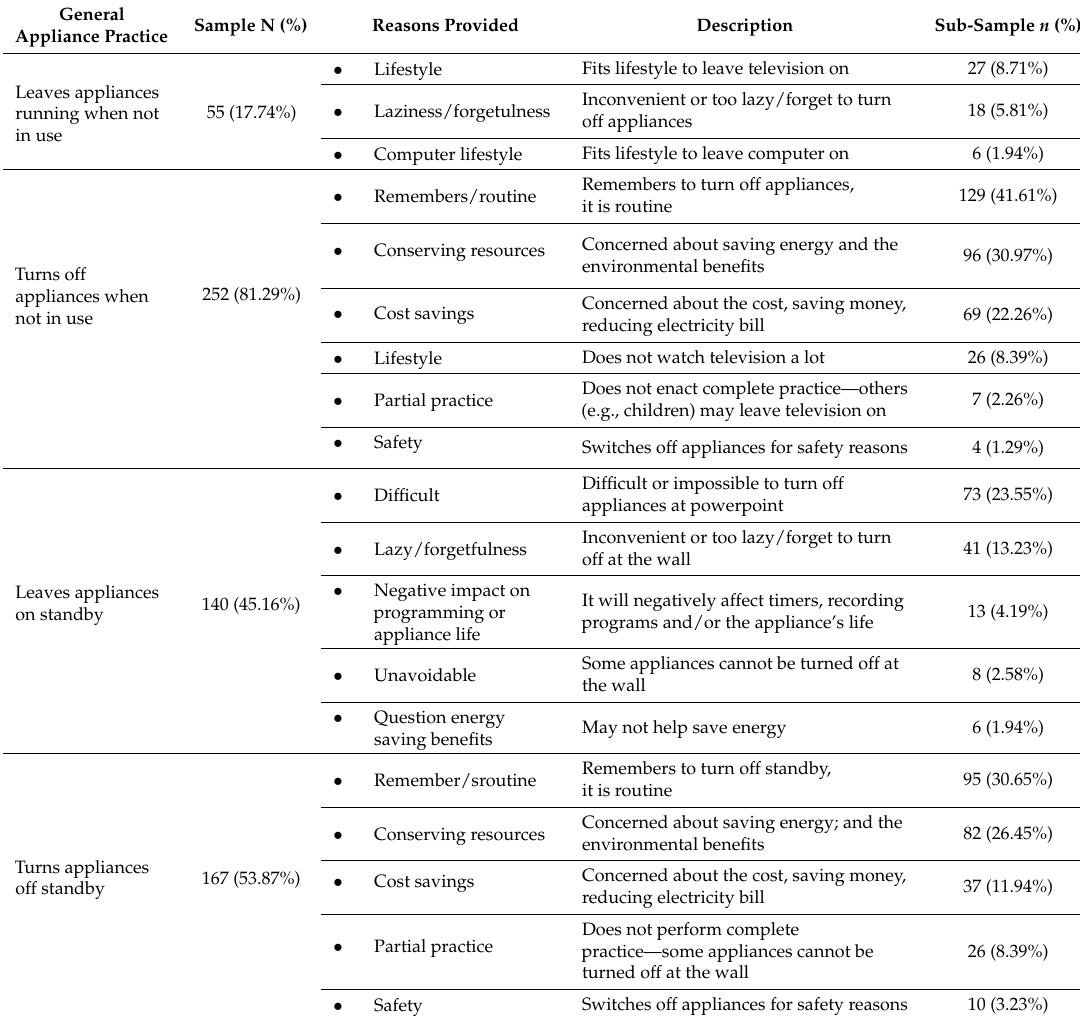
Table 5. Reasons given for energy-efficient and energy-inefficient general appliance usage practices ( N =